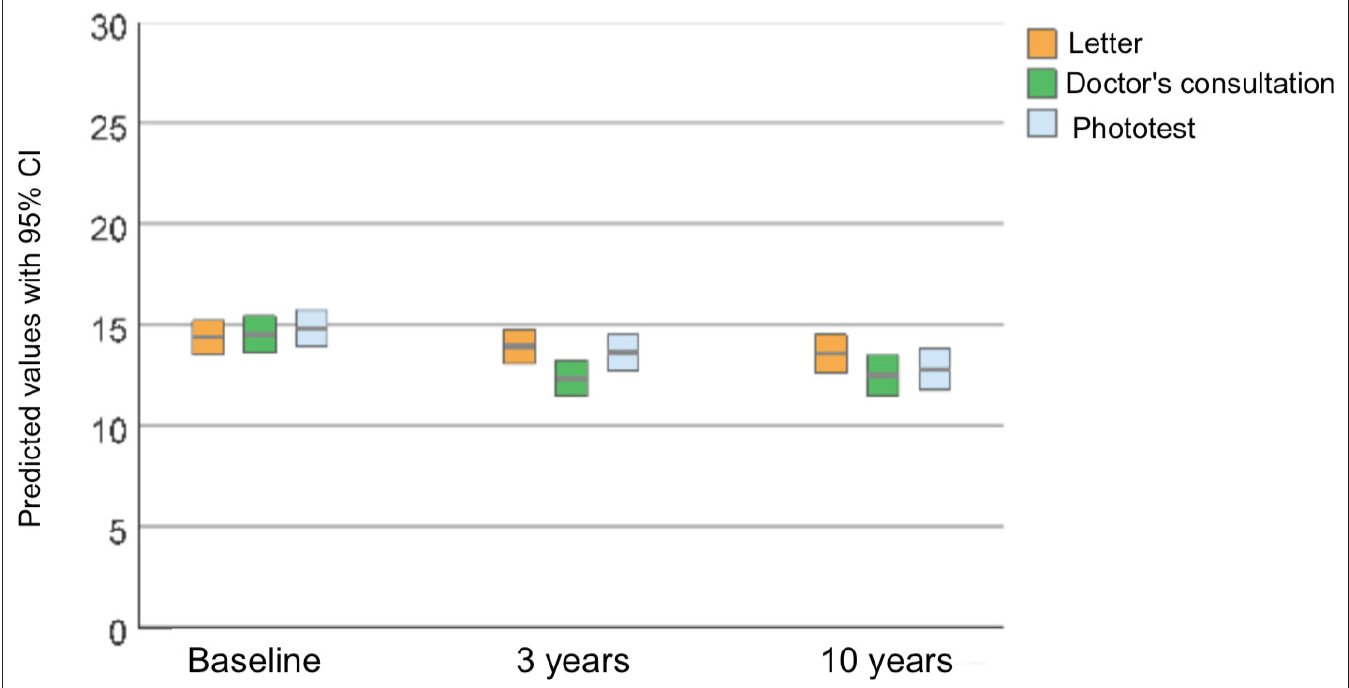
Figure 4 Predicted mean Sun Exposure and Protection Index score with 95% CI, at baseline and at 3- and 10-year follow-up, in each of the three intervention